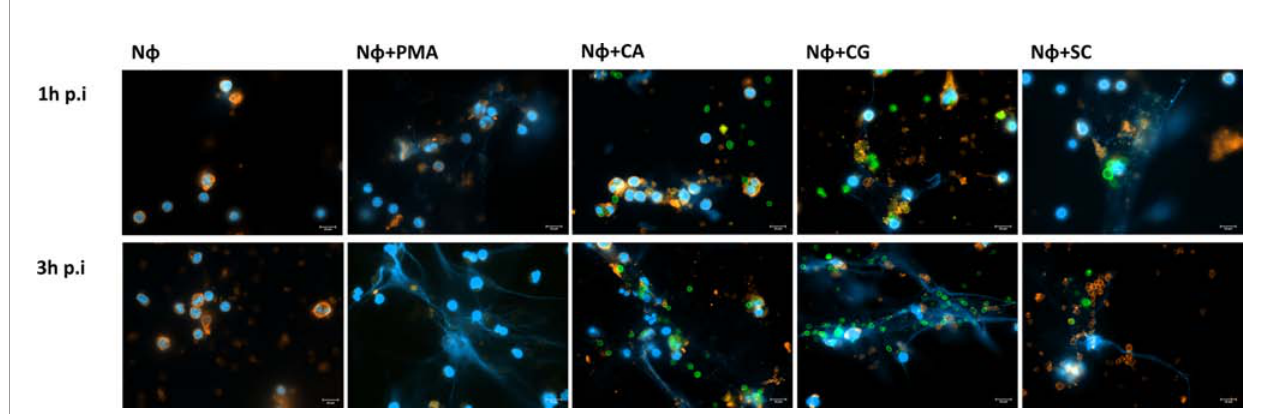
FIGURE 3 | NETs stimulation upon interaction of isolated neutrophils with yeast cells. Neutrophils (N ɸ ), neutrophils stimulated with PMA (N ɸ +PMA), neutrophils with C. albicans (N ɸ +CA), neutrophils with C. glabrata (N ɸ +CG), and neutrophils with S. cerevisiae (N ɸ +SC) were observed at 1 and 3 h post infection. The neutrophils ’ cell membrane sialic acids were stained with WGA, tetramethylrhodamine conjugate (red), nucleic acids stained with DAPI (blue), and each yeast cell stained with Oregon Green (green). Images are representative of sets of different experiments and were captured at 63× magni fi cation. Scale bars represents 10 m